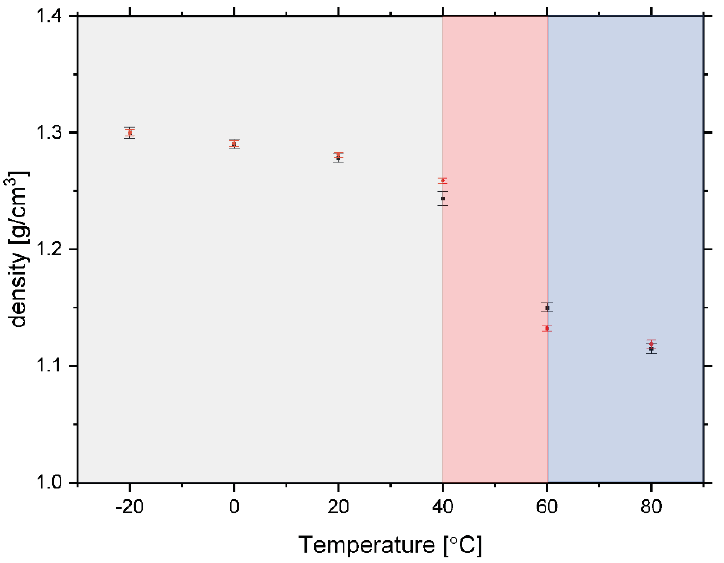
Figure 8. The estimated density values in the range of − 20 ° C to 80 ° C for the sample of rice pasta with the water content 0.1069 g/g d.m., calculated from the data recorded by neutron transmission (solid black points with error bars) and diffraction (solid red points with error bars). See text for details.